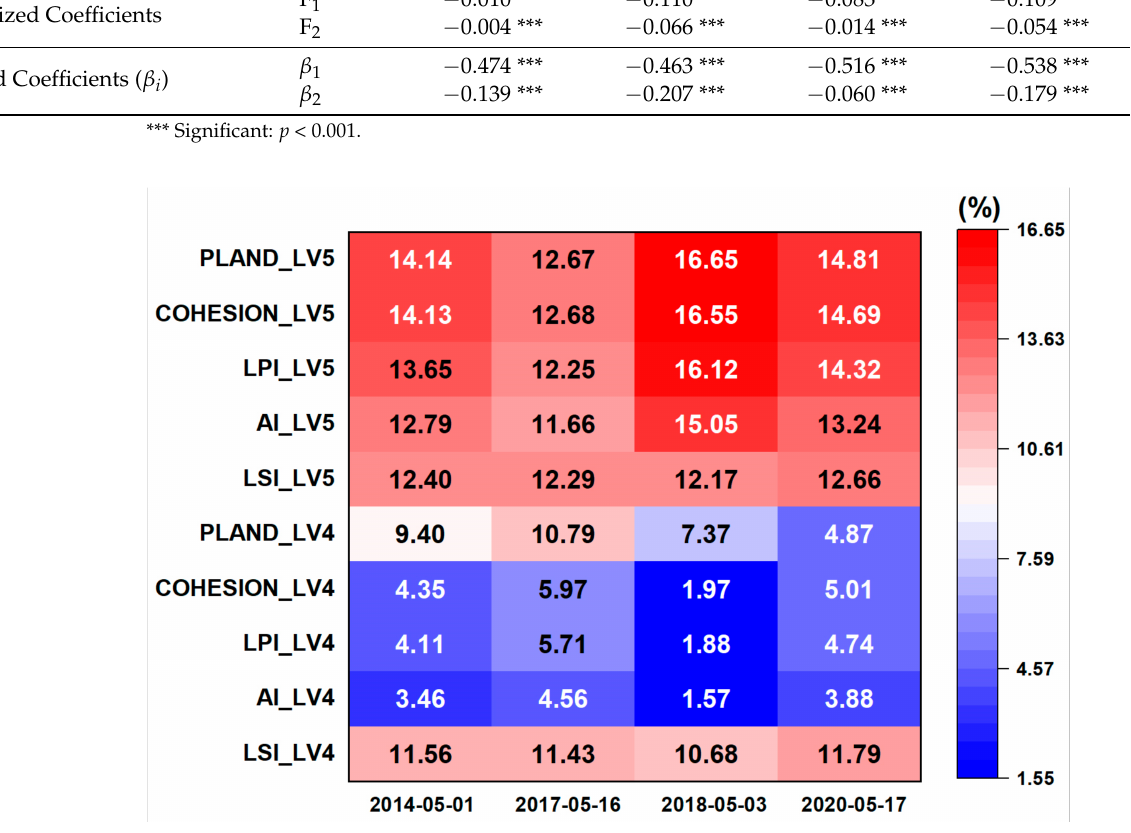
Figure 9. Heatmap of the impact weights of vegetation-fraction landscape metrics on land surface